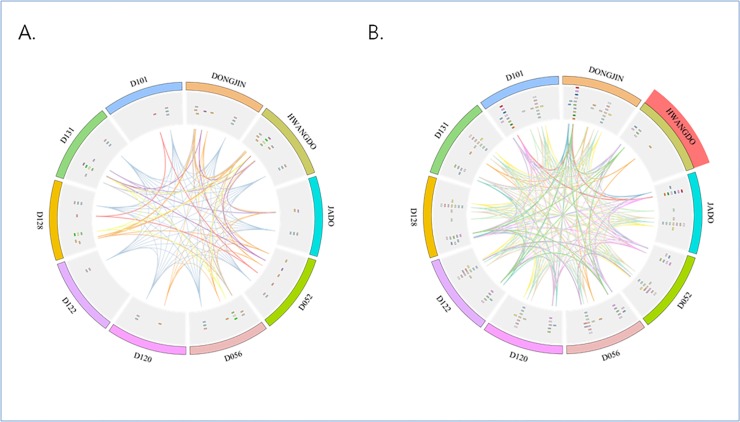
Circos diagram of the expression of genes related to magnesium transport and sulfur transport.The homologous genes in each group are plotted against nine other rice accessions as their counterparts. Individual magnesium-transporter and sulfur-transporter groups are shown as a similarity index representing the shared genes among the genomes. (a) Circos diagram of magnesium transporters. (b) Circos diagram of sulfur transporters. The Hwangdo cultivar had gene disruptions in the genes for sulfur-transporter biosynthesis.